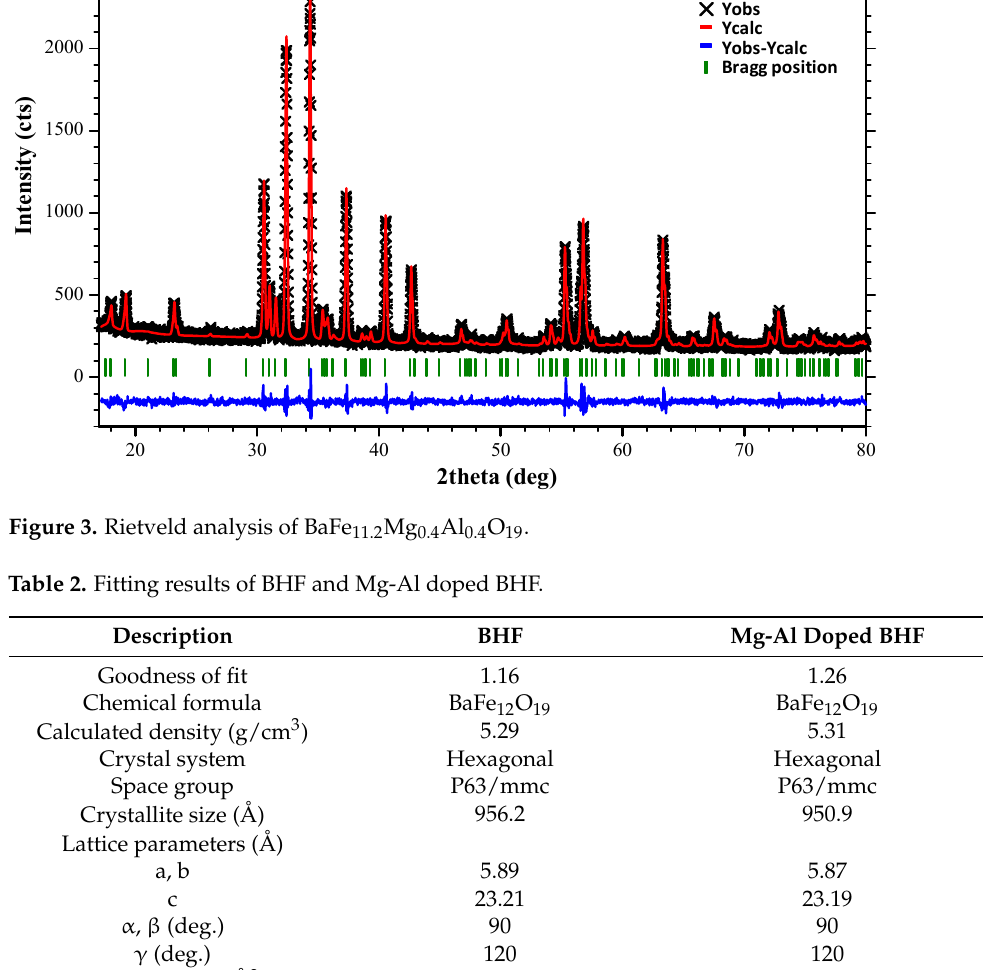
Table 2. Fitting results of BHF and Mg-Al doped BHF.